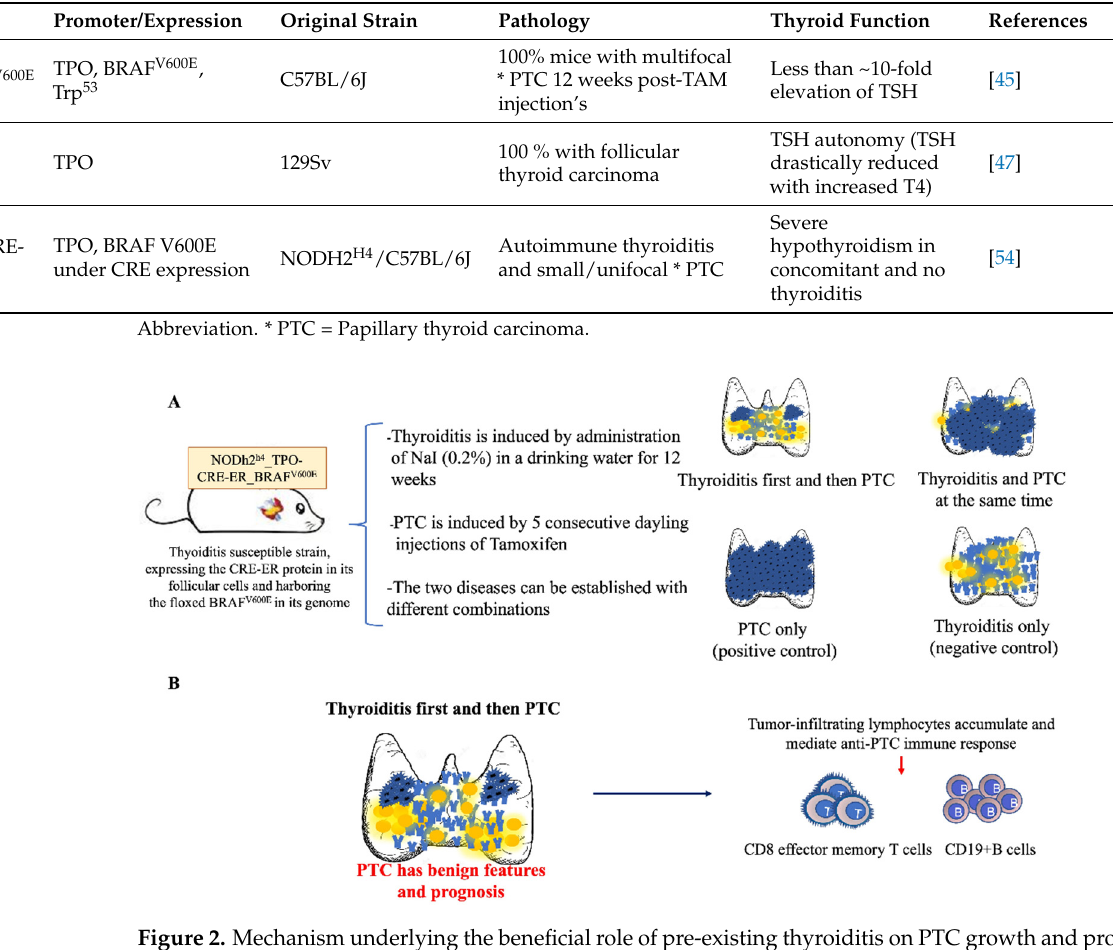
Table 2. Experimental Models of thyroid oncogenesis in transgenic animals.